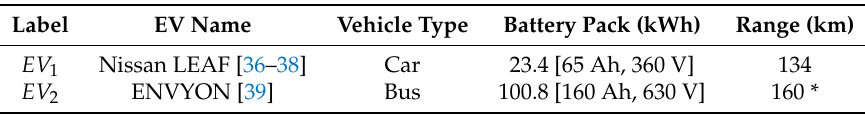
Table 1. EV characteristics.